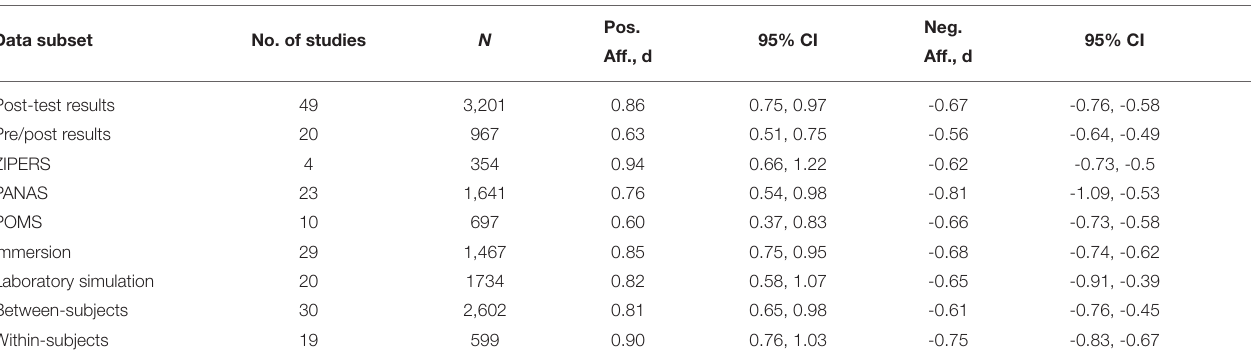
TABLE 3 | Summary of meta-analysis results for various data